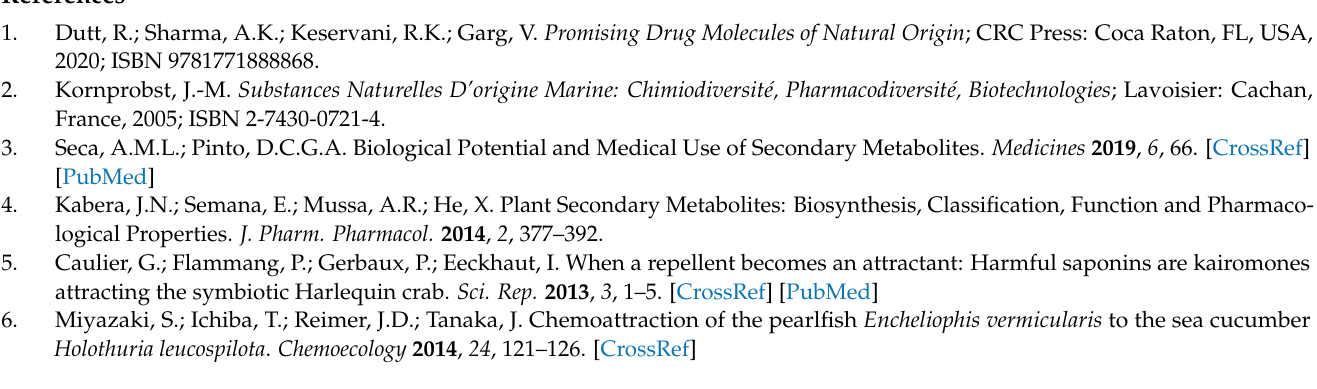
Figure S7: LC-MSMS(+) analysis of Holothuria scabra viscera saponin extract: CID spectrum (60 eV), recorded for the m / z 889 precursor ions [M − H+2Na] + at 11.36 min retention time (E 1 ); Figure S8: LC- MSMS(+) analysis of Holothuria scabra viscera saponin extract: CID spectrum (60 eV), recorded for the m / z 889 precursor ions [M − H+2Na] + at 12.16 min retention time (E 2 ); Figure S9: Microwave-assisted desulfation of Holothuria scabra sulfated saponins (150 ◦ C for 10 min): influence of the pH (7 to 14) on the desulfation reactions as estimated by LC-MS(+); Figure S10: Microwave-assisted desulfation of Holothuria scabra sulfated saponins (pH 14 for 3 min): influence of the temperature (80 to 110 ◦ C) on the desulfation reactions as estimated by LC-MS(+); Figure S11: Microwave-assisted desulfation of Holothuria scabra sulfated saponins (pH 14 at 100 ◦ C): influence of the time (1 s to 10 min) on the desulfation reactions as estimated by